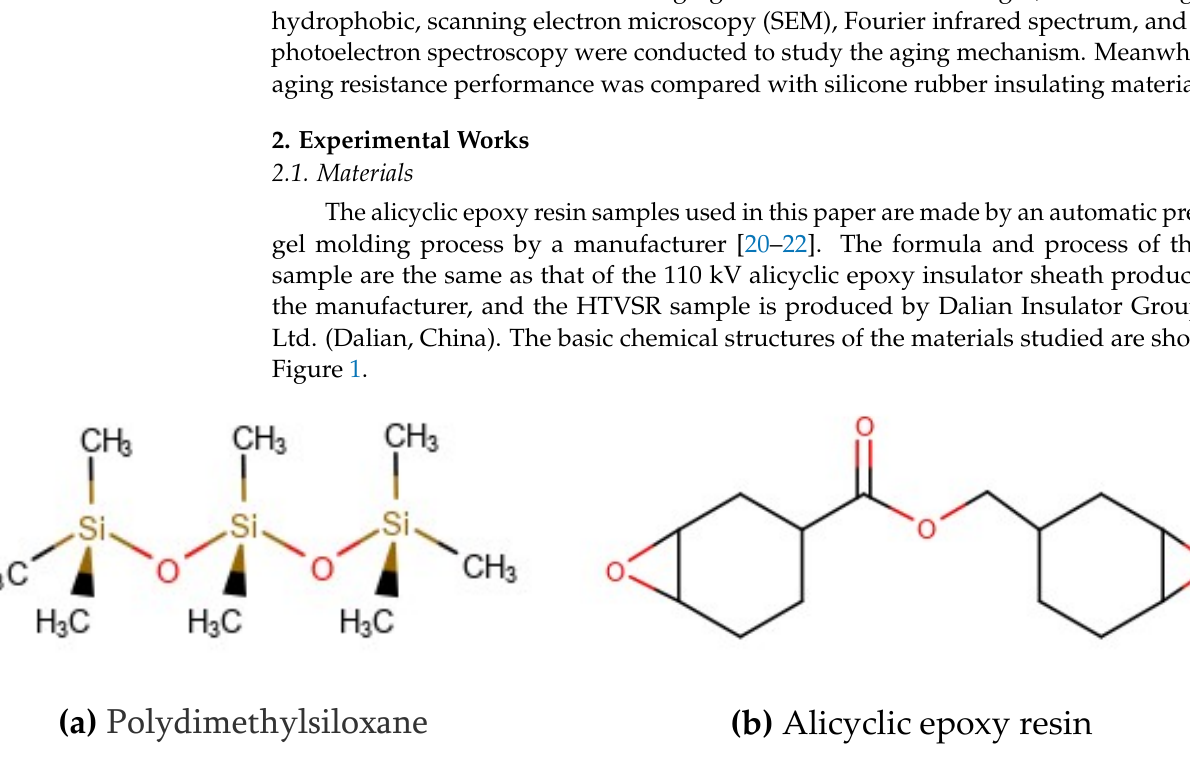
Figure 1. The chemical structure of materials: (a) HTVSR; (b) alicyclic epoxy resin.